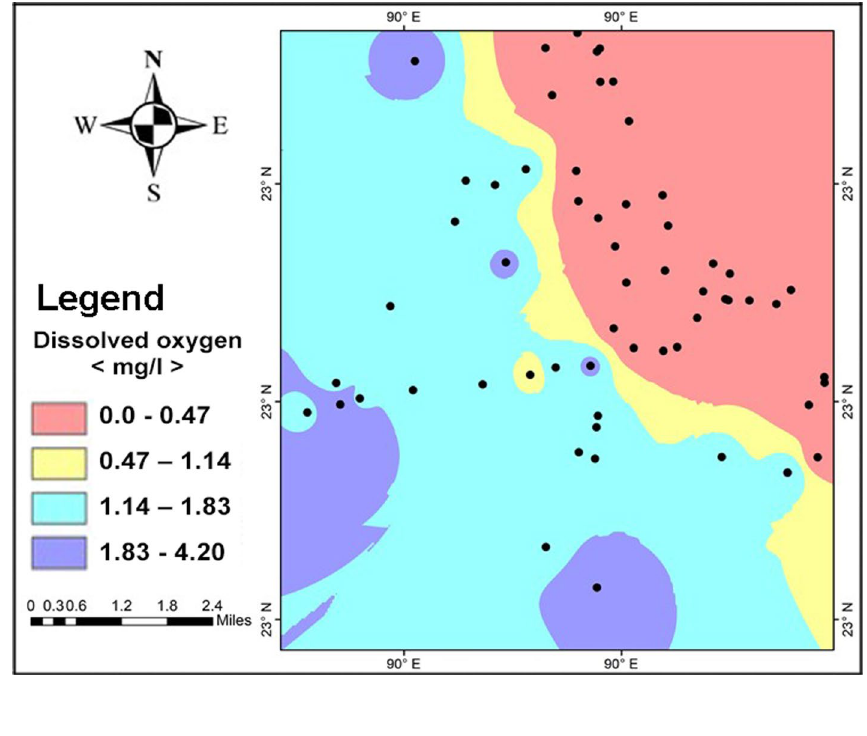
Fig. 6 Spatial distribution of TDS in selected tube wells